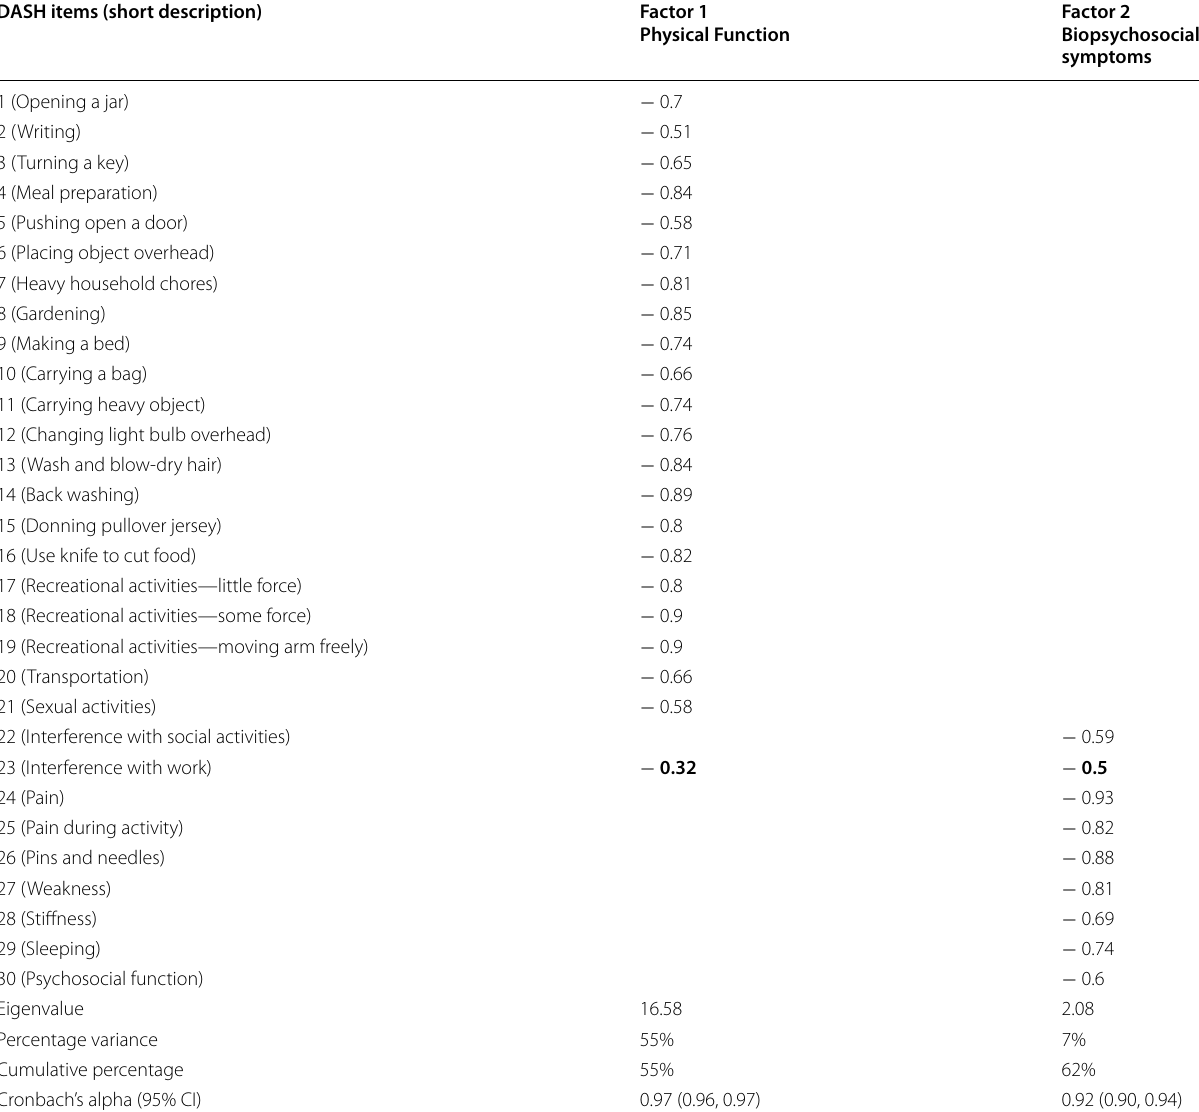
Table 3 Pattern matrix from EFA following oblimin rotation DASH items (short description)